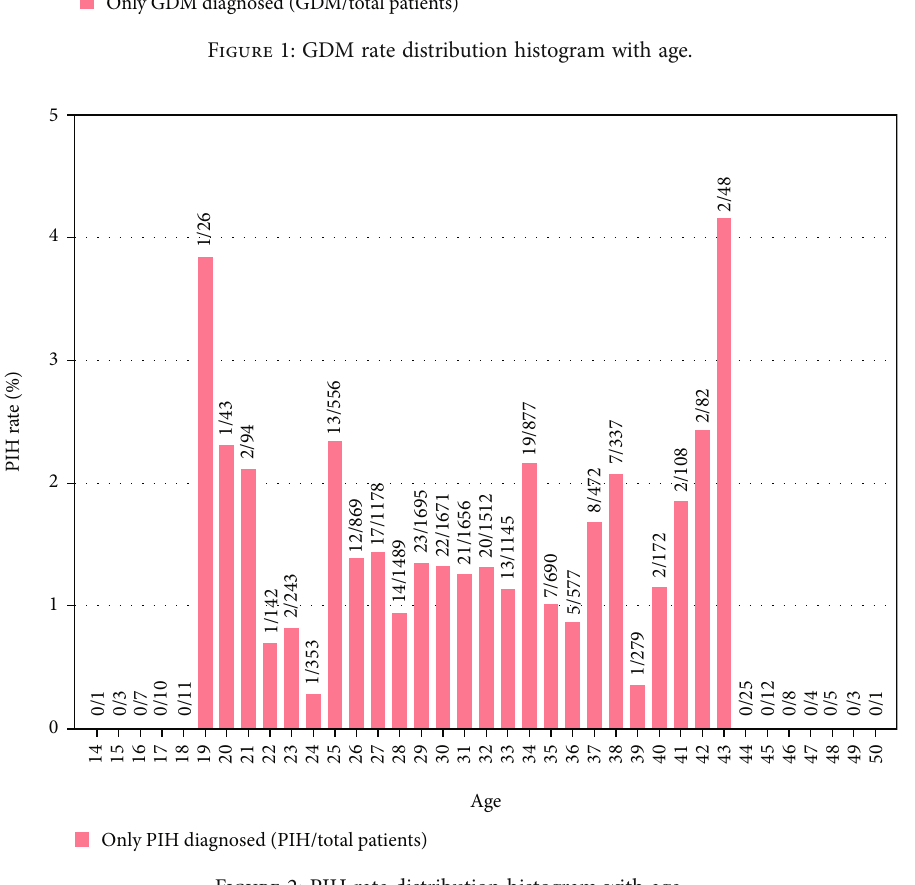
Figure 2: PIH rate distribution histogram with